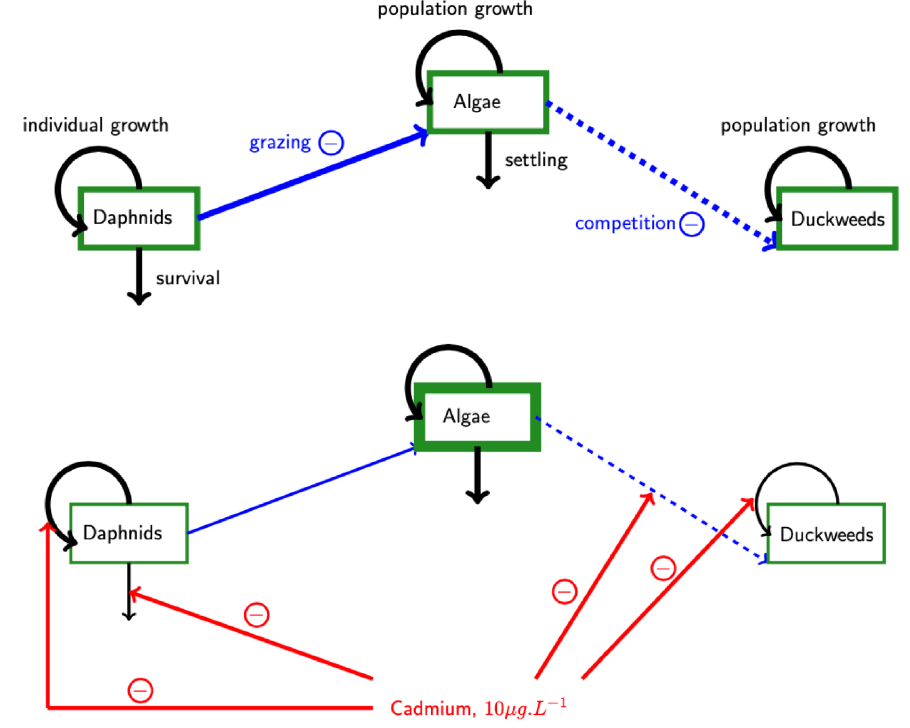
Figure 5. Global perturbation of the microcosm functioning without cadmium (above) and with cadmium ( 10 µ g/L, below). Green boxes represent species population, black arrows represent species processes, black arrows represent interactions between species, red ligthnings represent cadmium effect on the different pro- cesses. Thickness of boxes lines is proportional to population size and thickness of arrows is proportional to process